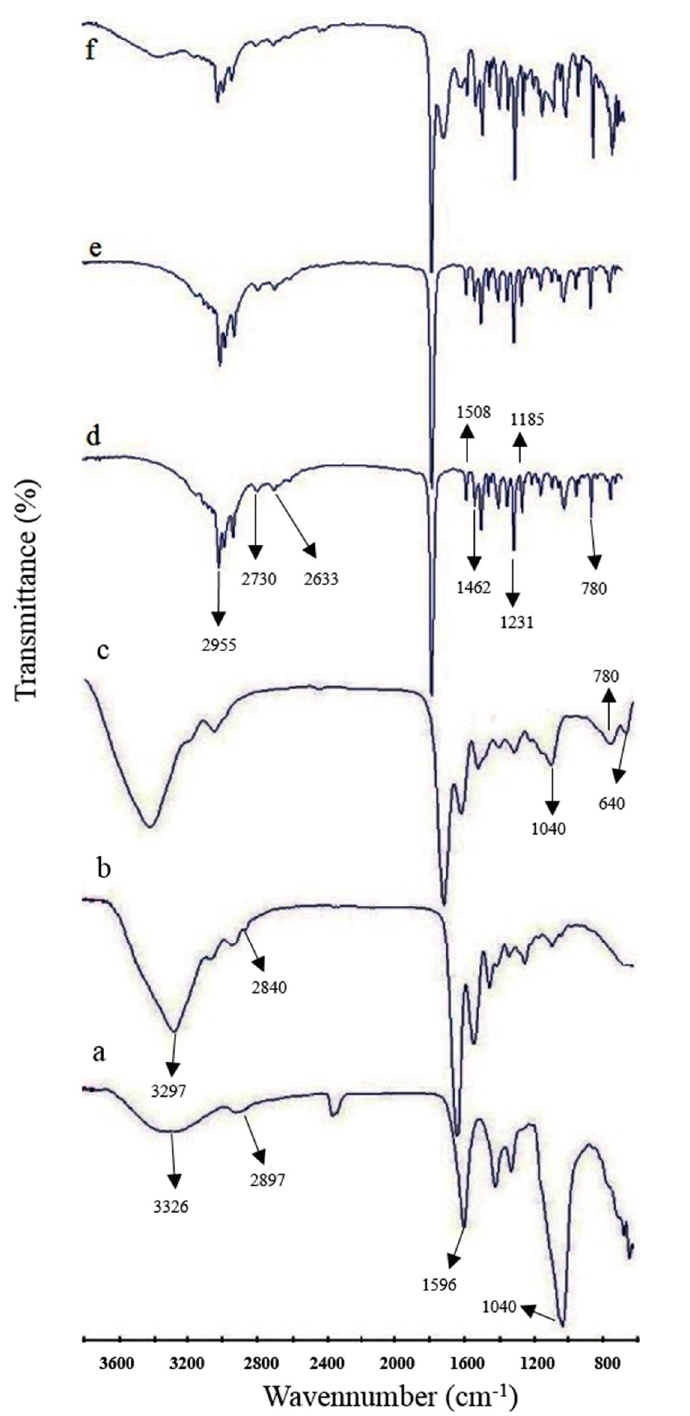
Figure 2. FT-IR spectrum of CMSP (a), gelatine (b), CMSP-gelatine complex coacervate (c), native ibuprofen (d), m-INN (e) and 45% m-INN loaded in CMSP-gelatine microcapsules